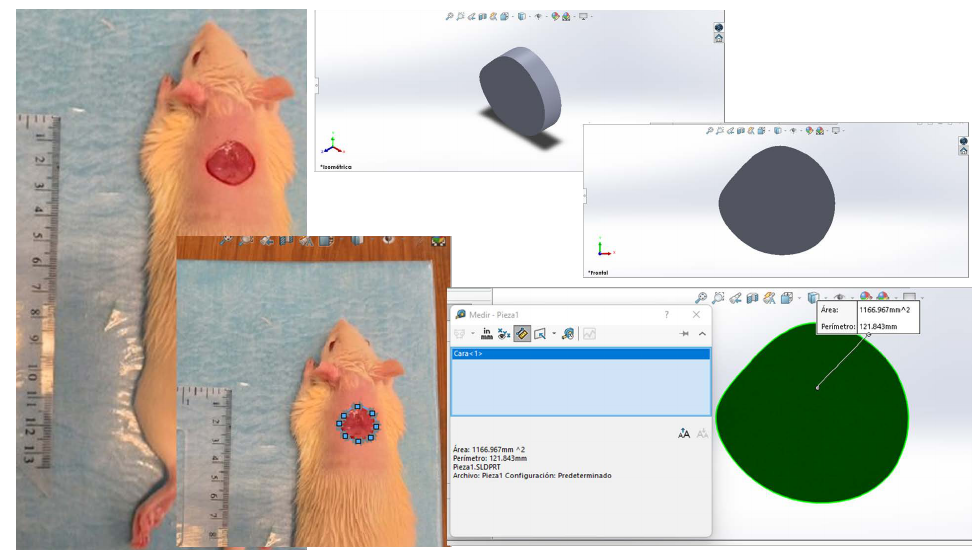
Figure 7. Measurement of the perimeter of the wound and calculation of the area using SolidWorks.